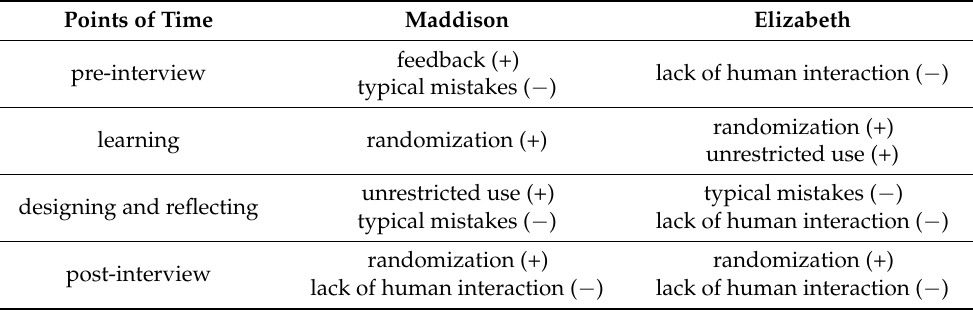
Table 3. Maddison’s and Elizabeth’s beliefs about possibilities and limitations of STACK during the semester. Points of Time Maddison